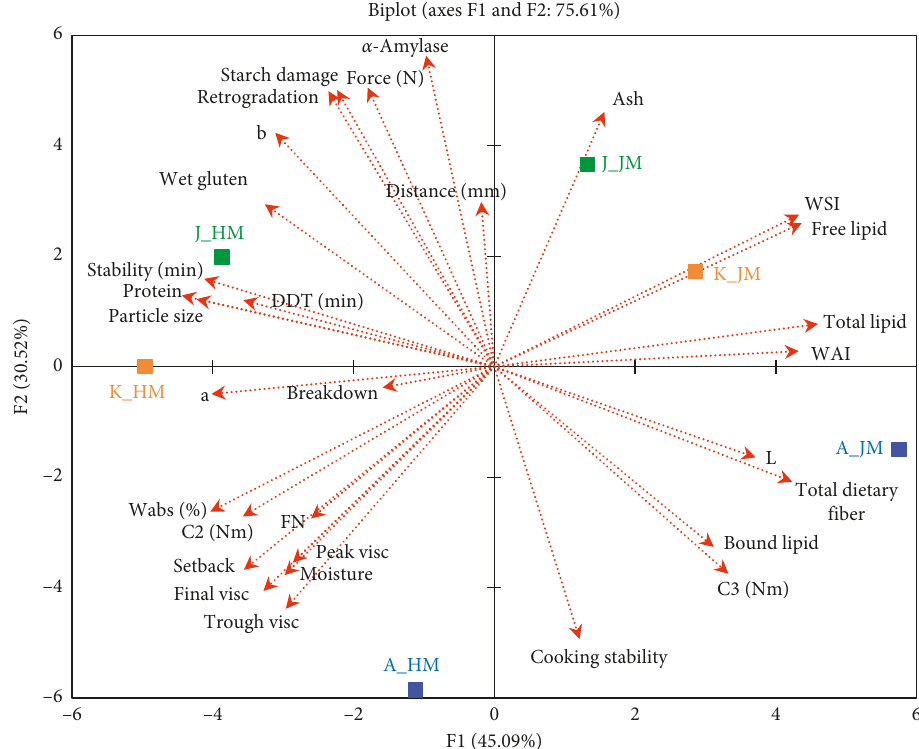
Figure 3: Principle component analysis (PCA) of WWF on proximate compositions and dough properties (K: Keumkang; J: Jokyung; A: Anzunbaengi; JM: jet mill; HM: hammer mill; WAI: water absorption index; WSI: water solubility index; Wabs: water absorption; DDT: dough development time; FN: falling